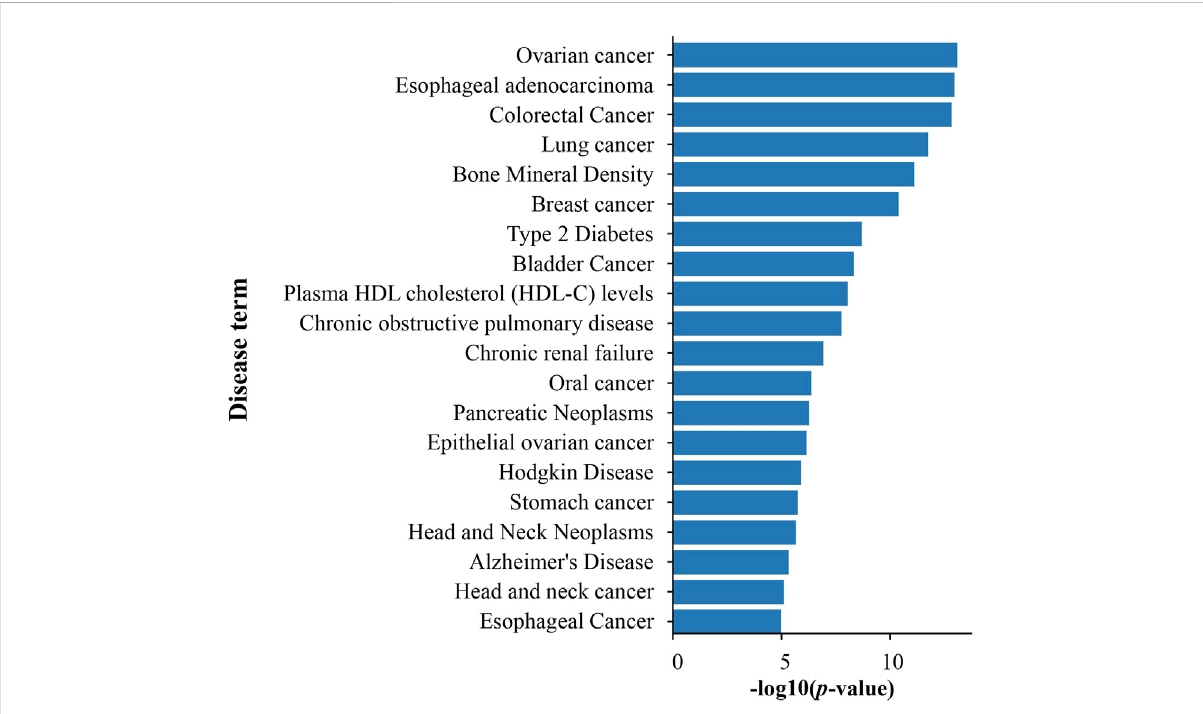
FIGURE 5 The top 20 disease enrichment analysis of DEGs on PSCE. Abscissa: log ( p -value), ordinate: disease terms. The length of the column indicated the signi fi cant -log ( p -value) of this disease term. The larger the -log ( p -value) was, the more signi fi cant the enrichment was.